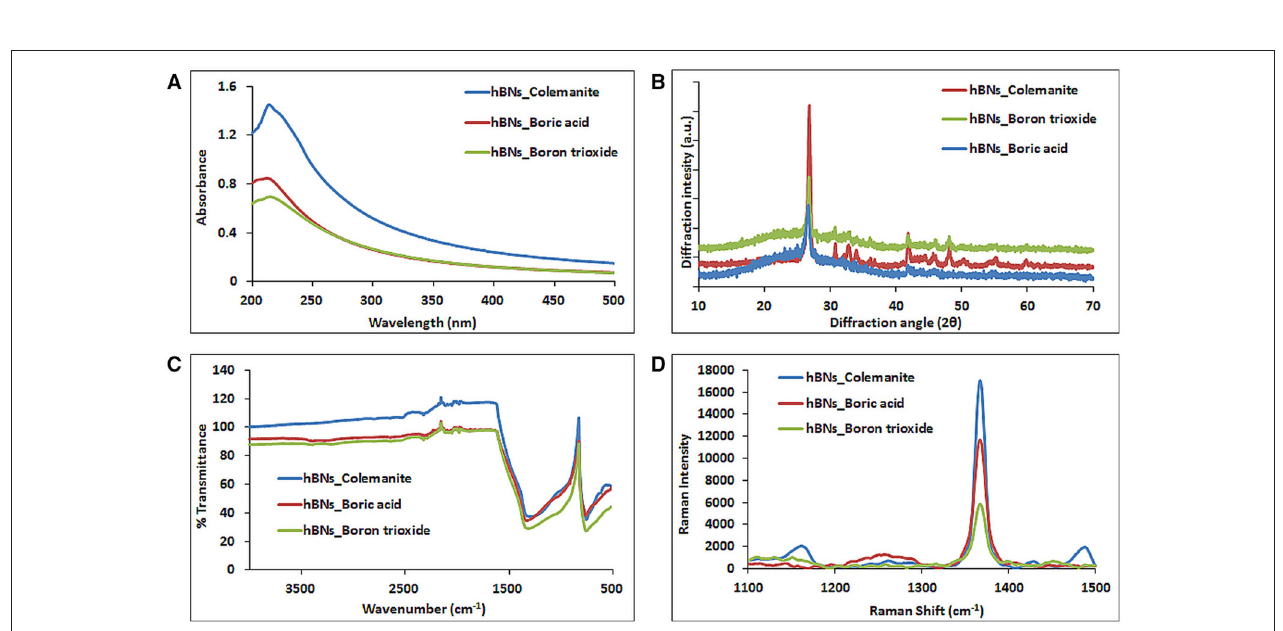
FIGURE 2 | Characterization of hBNs obtained from various precursors. (A) UV-Vis, (B) XRD, (C) FT-IR, and (D) Raman spectroscopy.